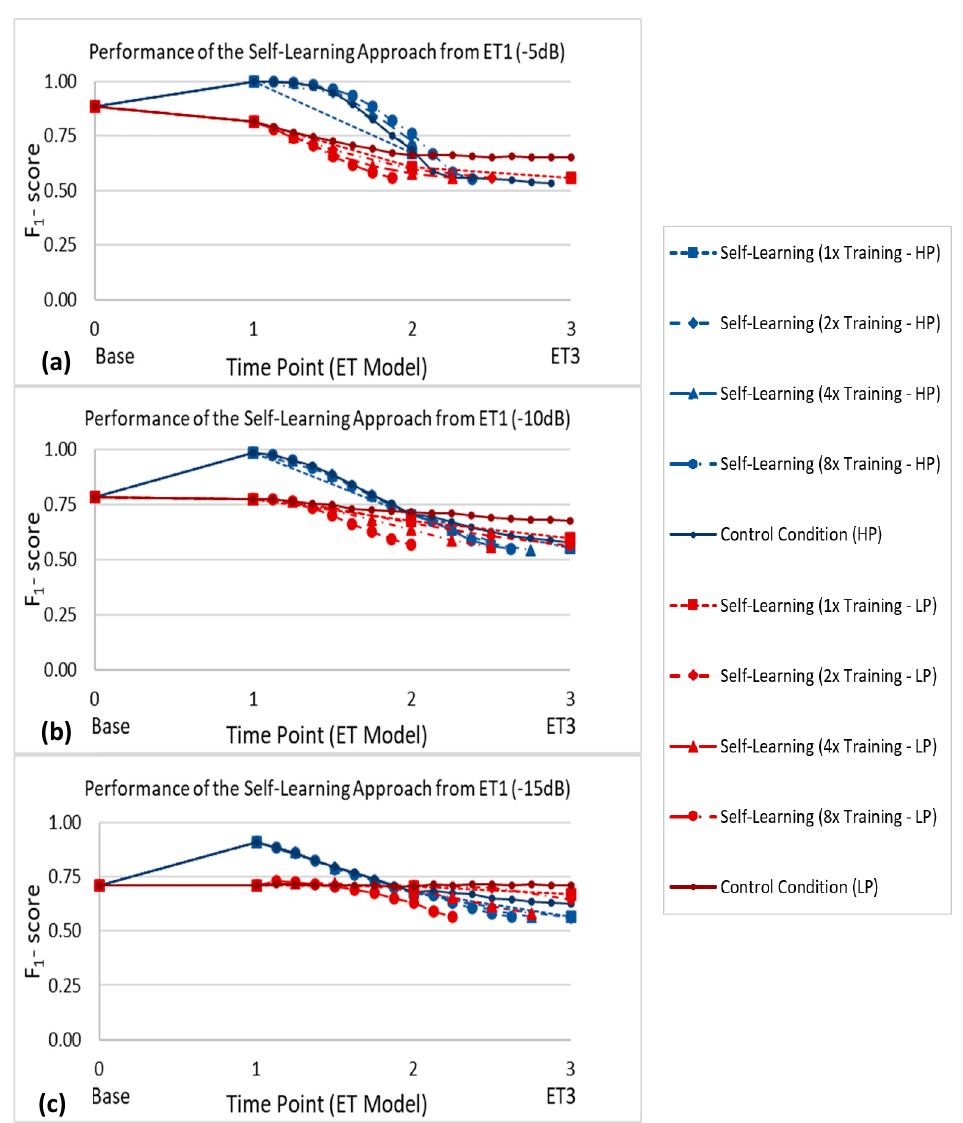
Figure 10. Classification performance of the self-learning approach using different training frequencies and starting at two different initial performance levels for SNRs of ( a ) − 5 dB, ( b ) − 10 dB, and ( c ) − 15 dB. Here, HP represents starting at the higher performance (HP) level shown as the blue curves, while LP represents starting at the lower performance (LP) level shown as the red curves. The starting point for HP was obtained by applying the periodic recalibration approach between Base and encapsulation tissue growth level 1 (ET1). The starting point for LP was obtained by applying the self-learning approach between Base and ET1. The standard deviations at each time point were all below 0.02 and are therefore not displayed here for ease of visualization.